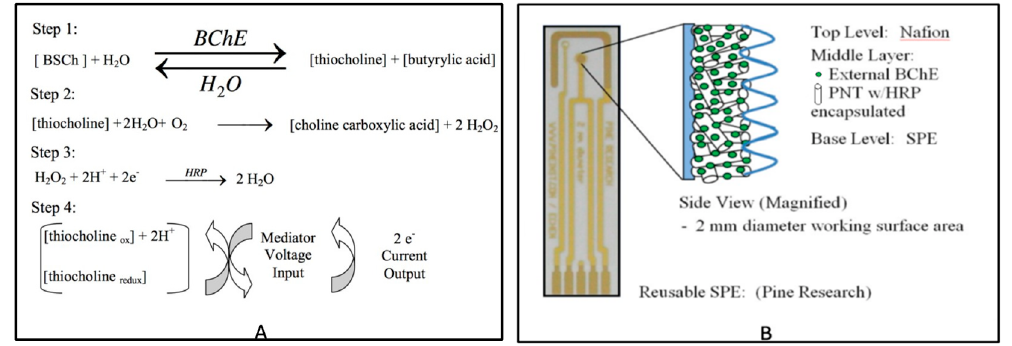
Figure 1. ( A ) Butyrylcholinesterase/butyrylthiocholine (BChE/BSCh) enzyme electrochemical reaction-based biosensor (Adapted from Andreescu, 2006) [15]; ( B ) Biosensor Construct.